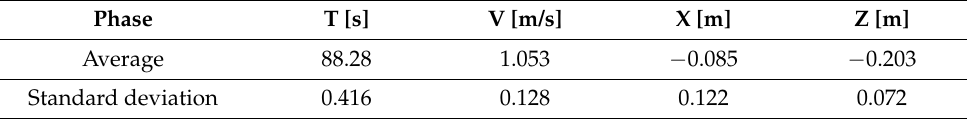
Table 13. Statistic elements of the landing position in case 1.